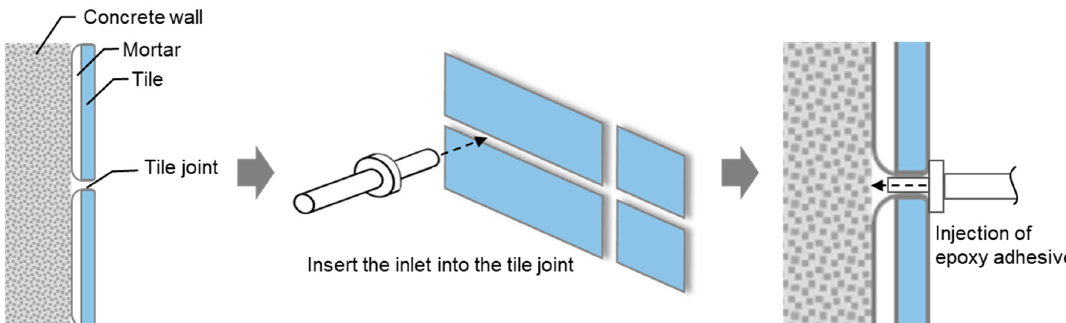
Figure 1. Outline of epoxy resin injection for reinforcement.